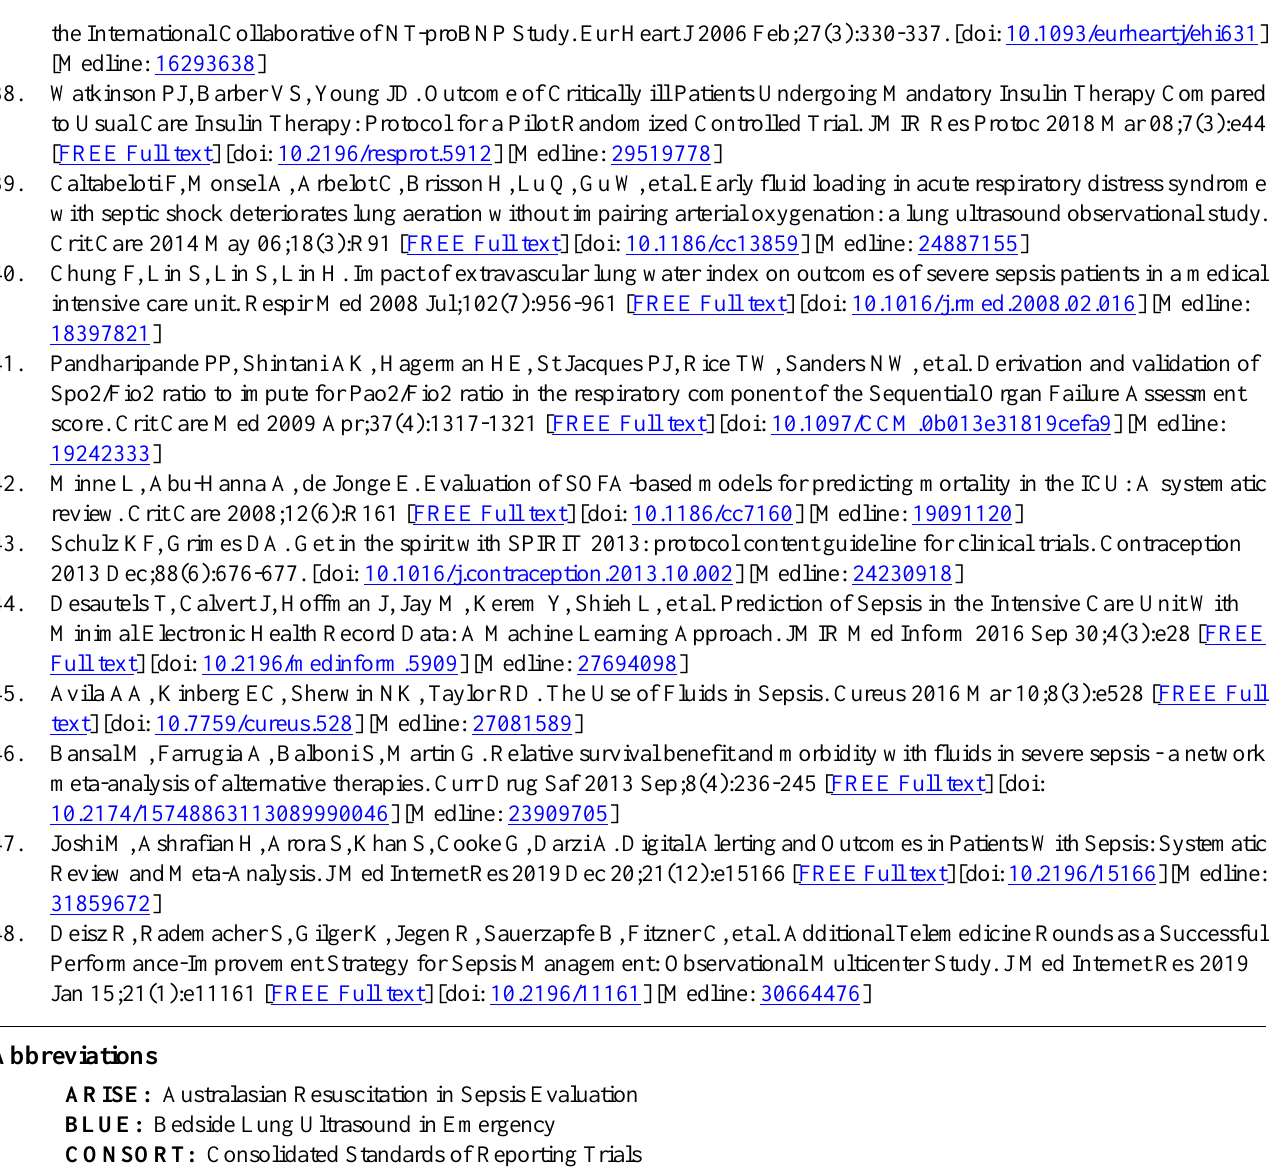
PICOT: Population, Intervention, Control, Outcome, and Time qSOFA: quick Sequential Organ Failure Assessment SOFA: Sequential Organ Failure Assessment SPIRIT: Standard Protocol Items: Recommendations for Interventional